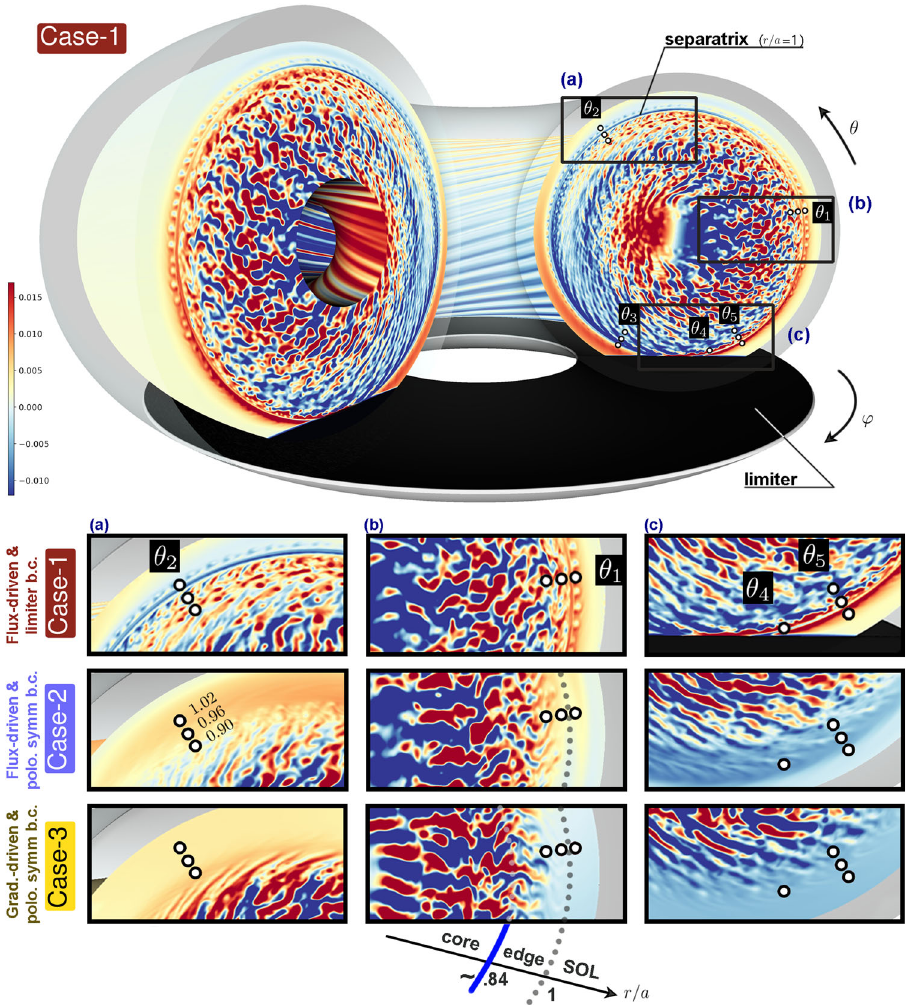
Fig. 1 Snapshots of the electrostatic potential in three different con fi gurations, at statistical equilibrium. Case-1 is the reference fl ux-driven con fi guration and features, as in experiments, a transition from closed to open fi eld lines in the Scrape-Off Layer (SOL) through introduction of a poloidally localised toroidal limiter (separatrix is at normalised radius ρ = r / a = 1) and a wall (at ρ = 1.3) within the computational domain. Case-2 differs from Case-1 through its external sink alone: uniformly distributed in the poloidal (along θ ) and of gradually increasing strength past ρ ≥ 1 (see Methods, section "Model equations"). Case-1 and Case-2 are initialised identically; subsequent discrepancies in their temporal evolution is thus direct incidence of the outer boundary condition alone. Case-3 is the gradient-driven twin of Case-2: it tests for the in fl uence of turbulence spreading on the global self-organised state. Background mean gradients for Case-3 are the converged pro fi les of fl ux-driven Case-2, other parameters being equal between both computations. Case-3 hovers throughout nonlinear evolution about the statistical state of fl ux-driven Case-2, effectively prescribing a scale separation between background and fl uctuations. For proper comparisons, the same radial-poloidal areas are magni fi ed for each Case: top of the machine [column a ]; low- fi eld side midplane [column b ] and bottom regions [column c ]. Reference (circled) positions are systematically displayed in all panels at various radial ( ρ = 0.9, 0.96 and 1.02) and poloidal ( θ 1 through θ 5 ) locations. The separatrix in Case-1 is clearly apparent; for comparison, it is drawn at the same locations for Case-2 and Case-3 as dotted grey lines in b . The solid blue line at r / a ~0.84 corresponds to the transition from (linearly) convectively unstable core to convectively stable edge [see Methods, section "Linear stability analysis" and ref. 37